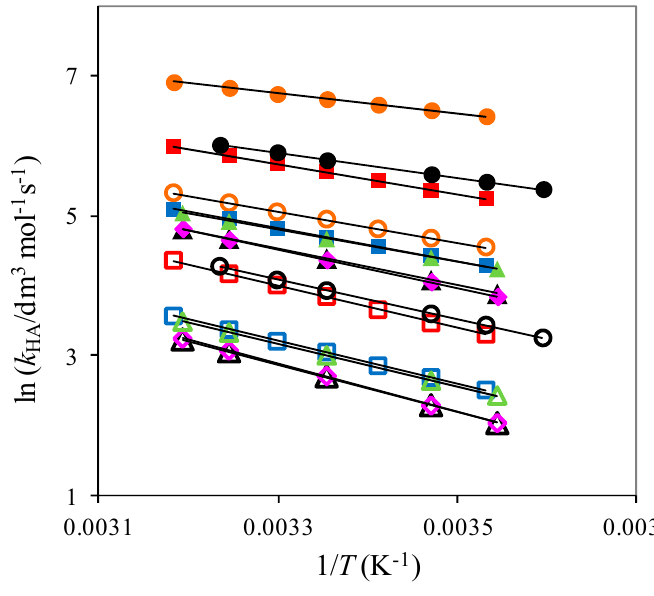
Figure 1. Arrhenius plot on the reaction of ascorbate and hexacyanoferrate(III) ion in presence of low concentrations of different quaternary ammonium salts in H 2 O (filled symbols) and D 2 O (hollow symbols). Key: green triangle, 0.005 M TMACl; black triangle, 0.005 M TPACl; magenta diamond, 0.005 M TBACl; blue square, 0.01 M TEACl; orange circle, 0.006 M PQCl 2 ; red square, 0.1 M AChCl; black circle, 0.1 M BTMACl. Abbreviations as noted in Table 1.